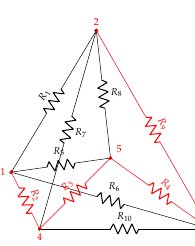
Figure 6. Resistive grid configuration with a complete path for delivering merchandise.